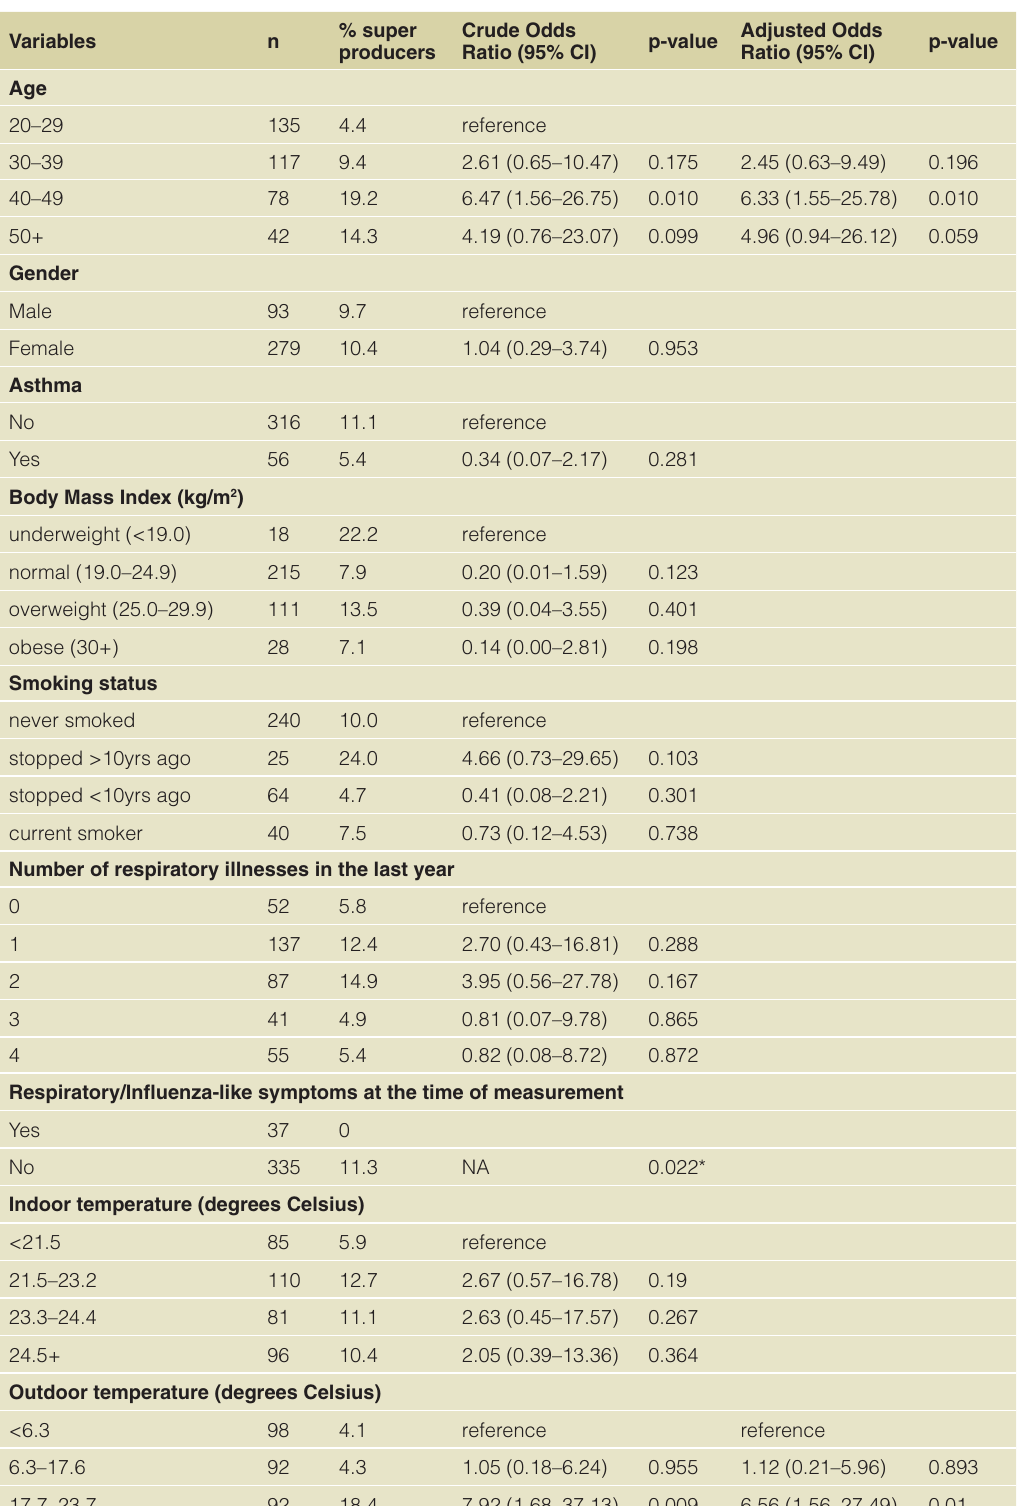
Table 2. Results of the multilevel linear regression analysis on factors associated with log transformed submicron bio-aerosol count/L. * 2-sided Fisher’s exact